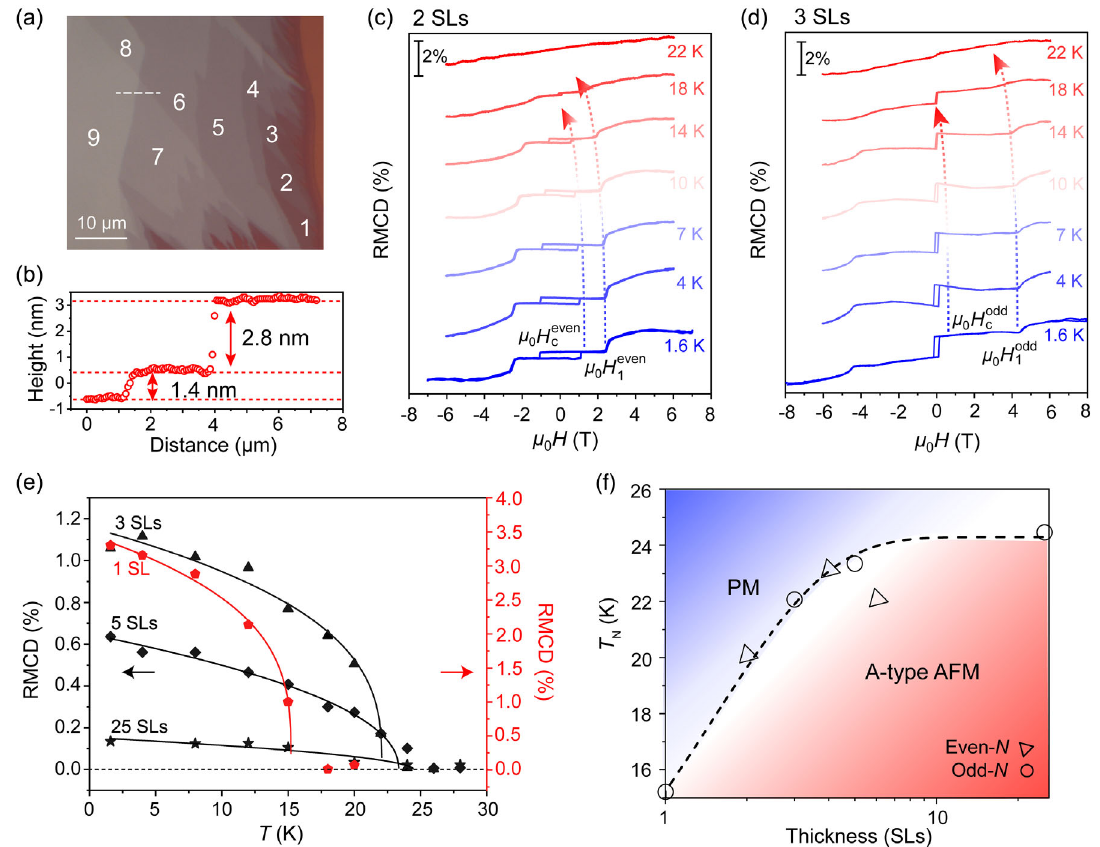
FIG. 3. Temperature-dependent RMCD measurements with different thicknesses and the thickness-temperature phase diagram of MnBi 2 Te 4 . (a) Optical image of the stepped MnBi 2 Te 4 flakes with 1 SL to 9 SLs. (b) Line height profile of the MnBi 2 Te 4 flakes, along with the white dashed line in panel (a). (c) RMCD sweeps for the 2-SL sample at a temperature range that passes through its T . The N spin-flop field ( μ 0 H 1 ) decreases as the temperature increases and eventually vanishes at about 20 K. (d) RMCD sweeps for the 3-SL sample at a temperature range that passes through its T . The coercive field and remnant RMCD signal of the magnetic loop decrease as N the temperature increases, and both eventually vanish at about 22 K. (e) Remnant RMCD signal as a function of temperature for the Þ β , selected few- N SL flakes (1 SL, 3 SLs, 5 SLs, and 25 SLs). The solid lines are least-squares criticality fits with the form ð 1 − T=T N and the black dashed line represents zero RMCD signal. (f) Layer number-temperature phase diagram of the MnBi 2 Te 4 flakes. PM denotes the region where the flake is paramagnetic; A-type AFM denotes the region where adjacent ferromagnetic SLs couple antiferromagnetically with each